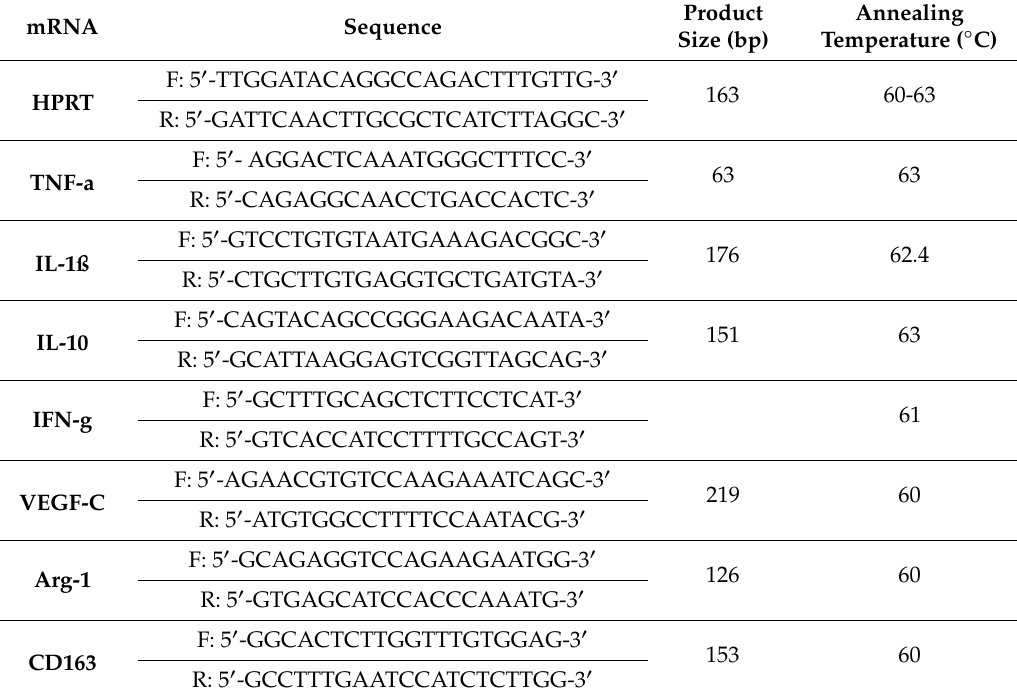
Table 1. Primer Used for Real-Time